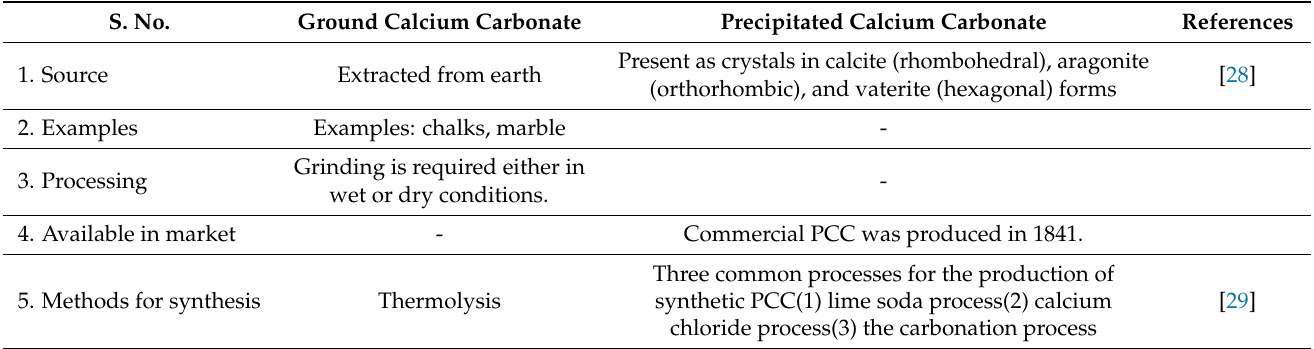
Table 1. Differences between ground and precipitated calcium carbonate particles. S. No.